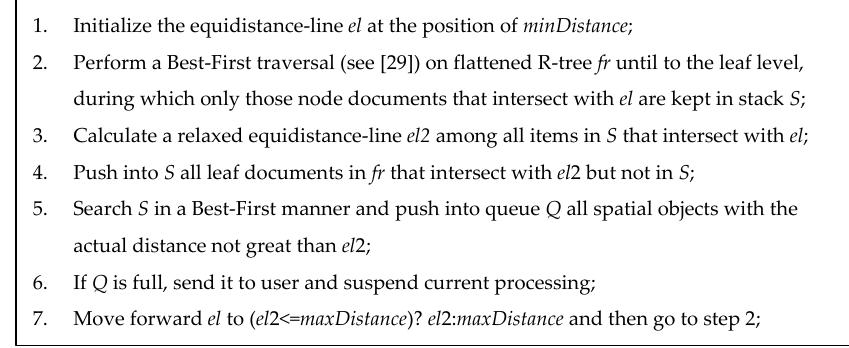
Figure 7. Processing a MongoDB near query with a flattened R-tree.